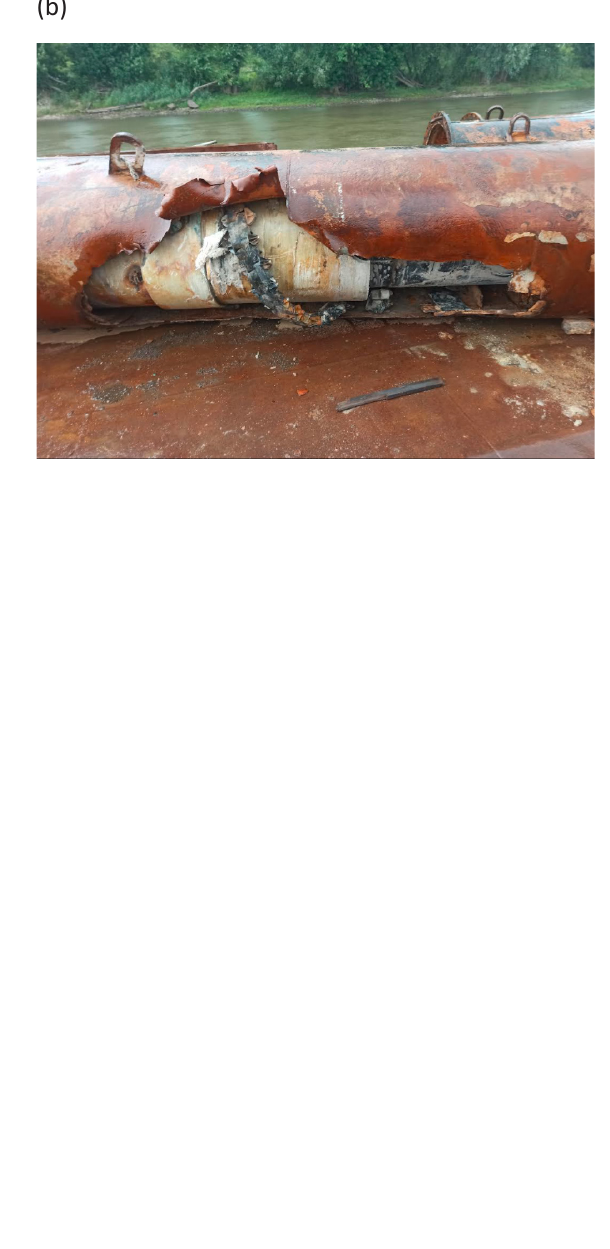
at distance L must be greater than B MZ MZ MZ